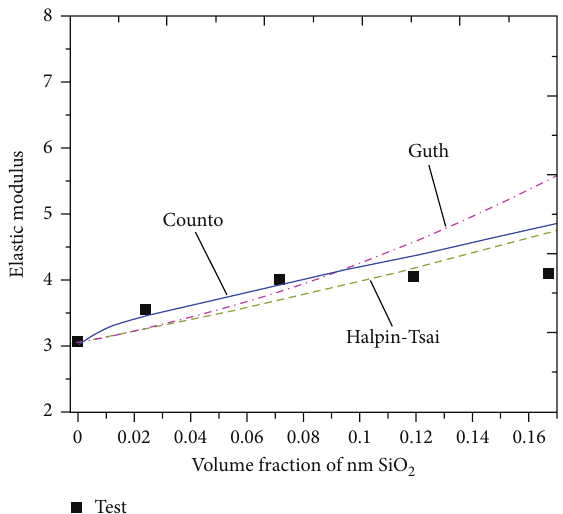
the volume fraction 2.39 vol.%, 7.16 vol.%, 11.93 vol.%, and 16.70 vol.%, respectively.